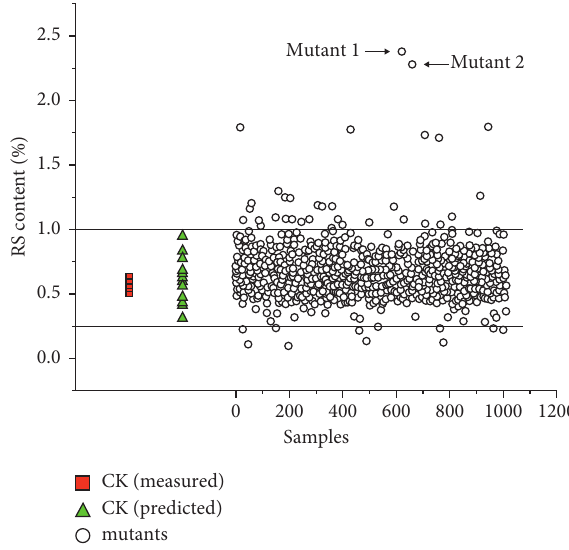
Figure 4: Application of the best ATR-MIR model to screen the high grain RS content mutant lines from wheat mutant Table 4: Verification of the best ATR-MIR calibration model screened high grain RS wheat mutants by the chemical measured method.